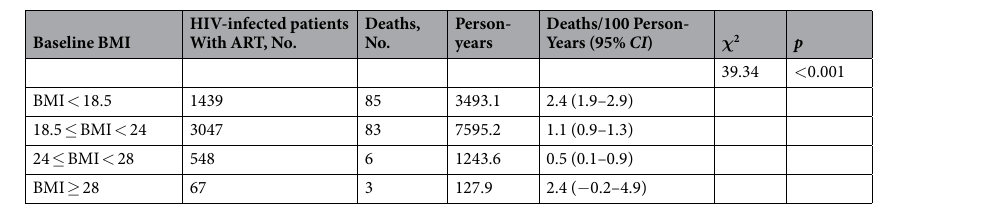
Table 2. Mortality rates of HIV-infected patients who started